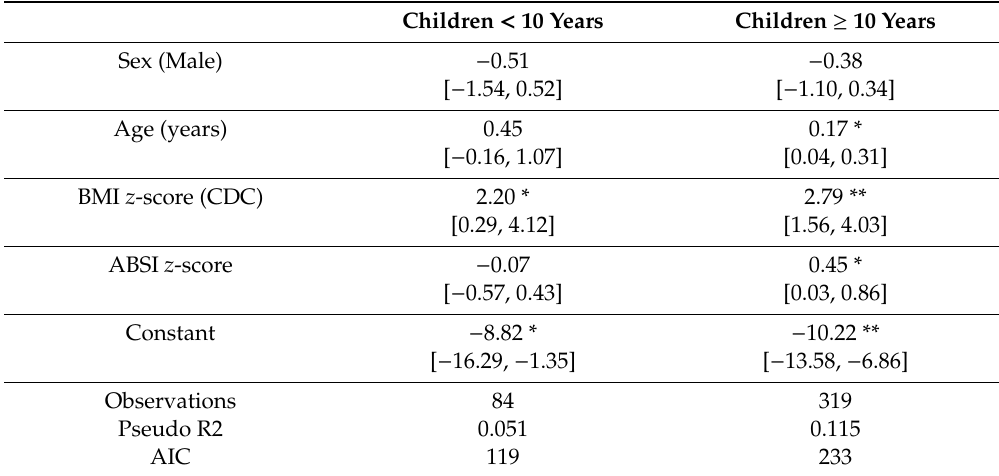
Table 4. Joint contribution of body mass index (BMI) and body shape index (ABSI) in the prediction of metabolic